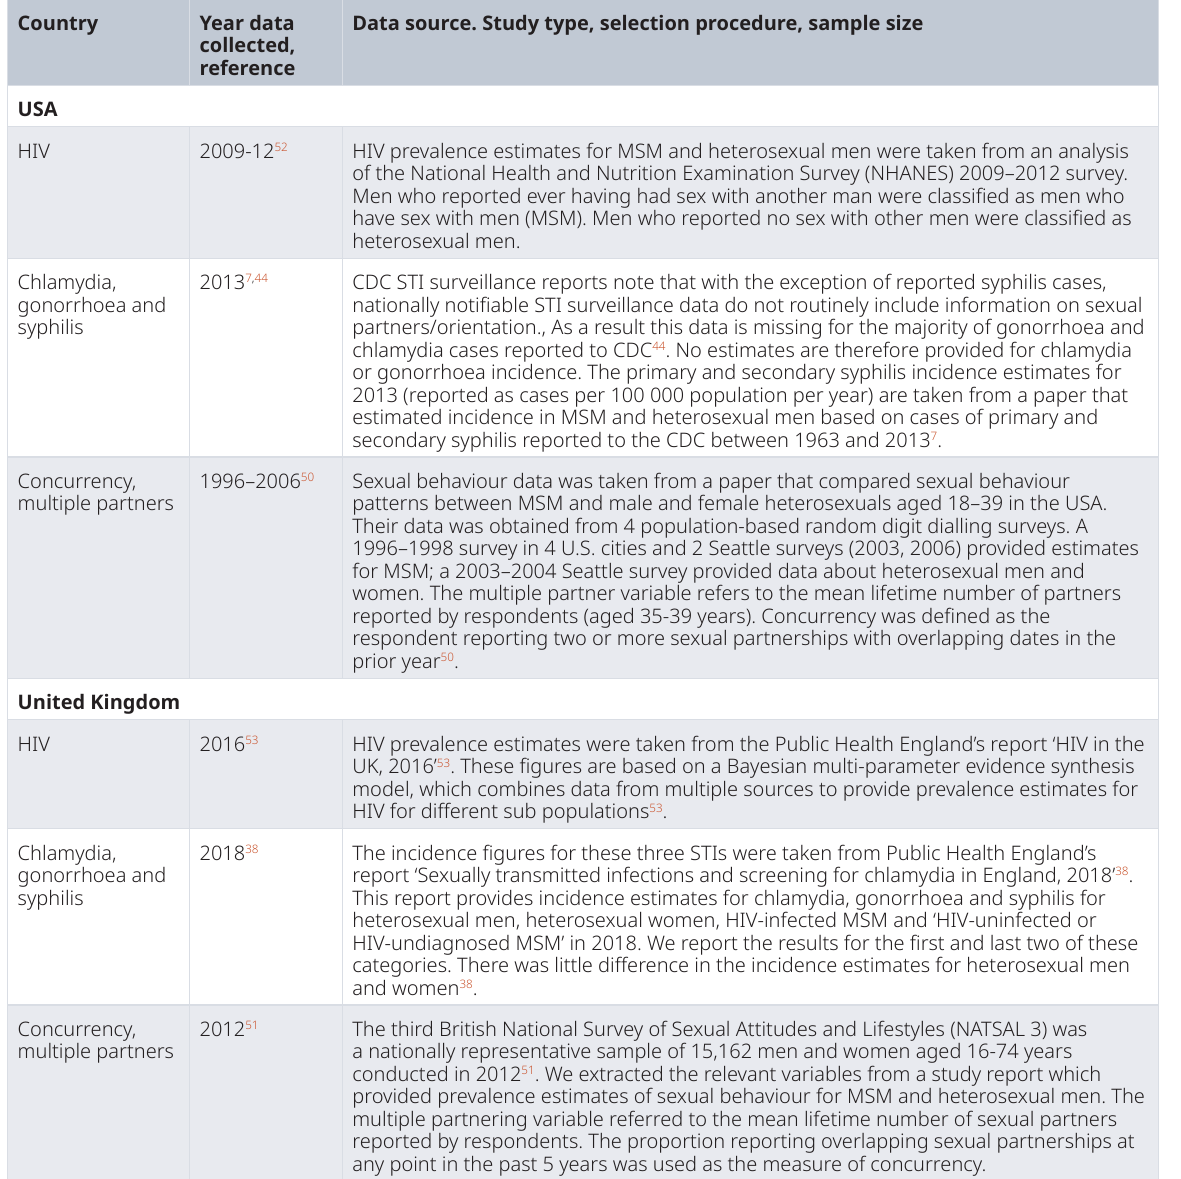
Table 2. Description of sources of data for comparison between men who have sex with men and heterosexual men: prevalence of STIs, multiple partners and concurrency. Country Year data